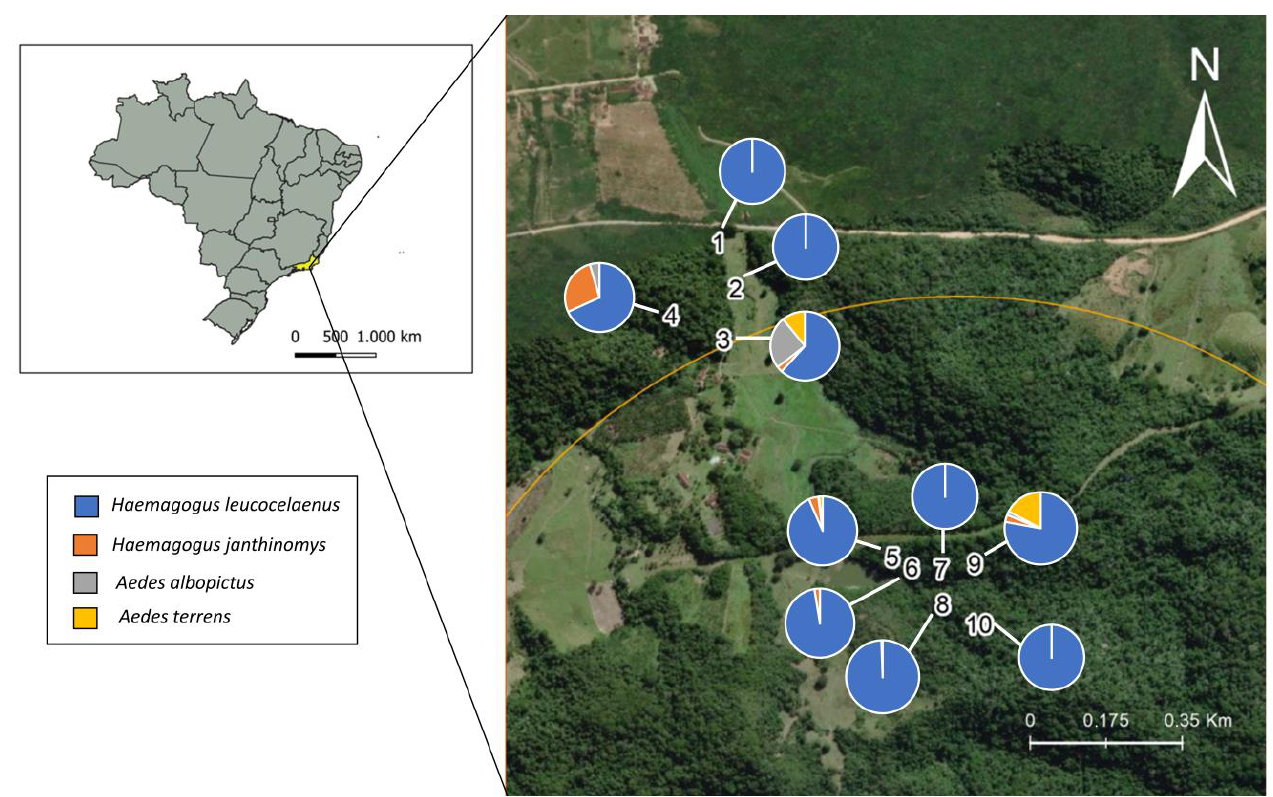
Figure 5. Relative frequencies of breeding sites containing immature stages of Hg. leucocelaenus , Hg. janthinomys , Ae. albopictus and Ae. terrens , collected from September 2019 to January 2021 in RPPN Gaviões.